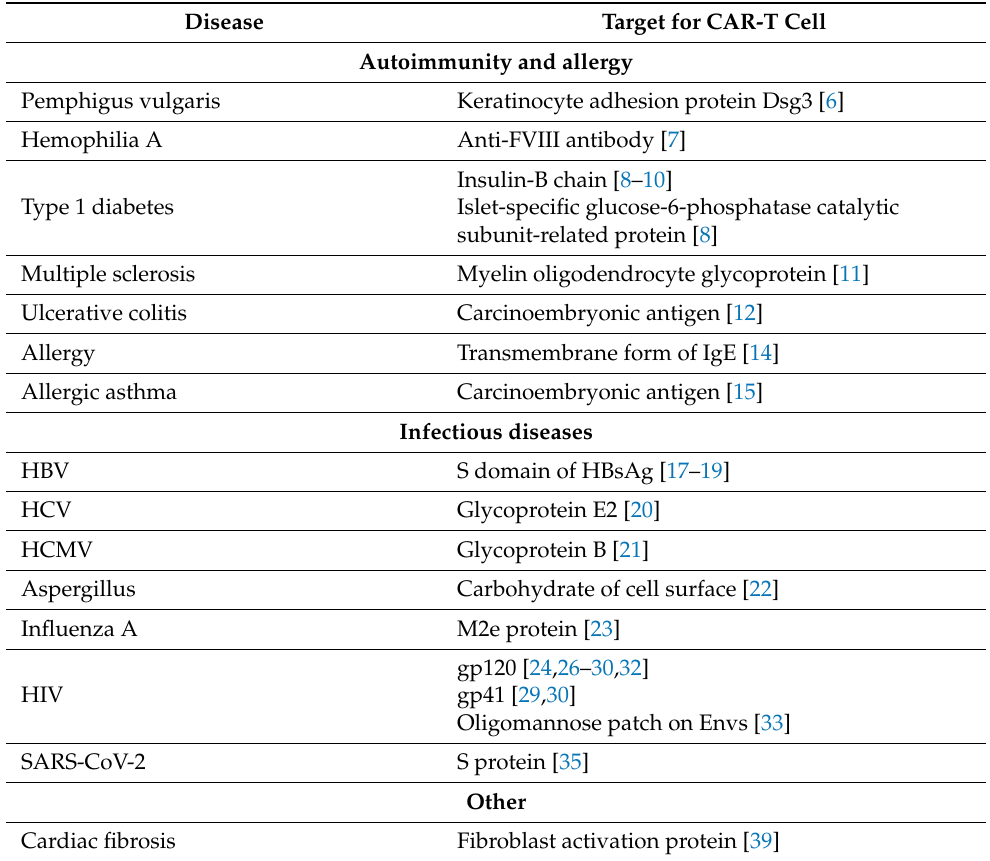
Table 2. The list of diseases that can potentially be treated with CAR-T cell therapy and the respective target molecules. Disease Target for CAR-T